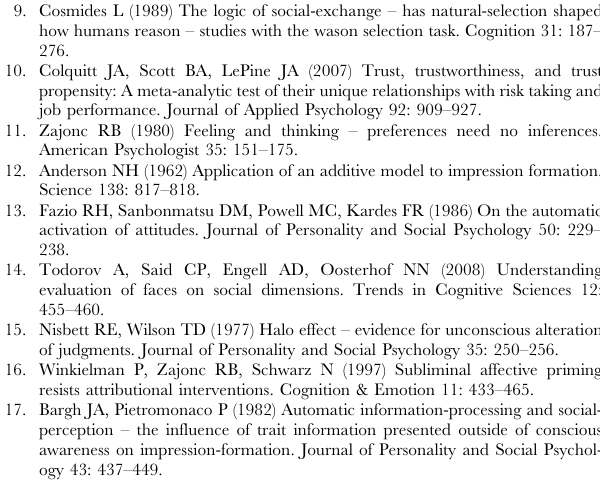
Table S1 Means and standard deviations of ratings in partner judgments and memory tests. Table S2 The result of post-hoc tests for main effects of MR on partner judgments post-game. Table S3 The result of post-hoc tests for main effects of MR on the change of ratings in partner judgments from pre- to post-game. Table S4 The results of the post-hoc tests for main effects of MR on memory tests. Table S5 Because of significant interactions between the MR and gender, we conducted a simple main effect test in post-game partner judgments. Table S5 presents the difference of mean ratings between male and female participants